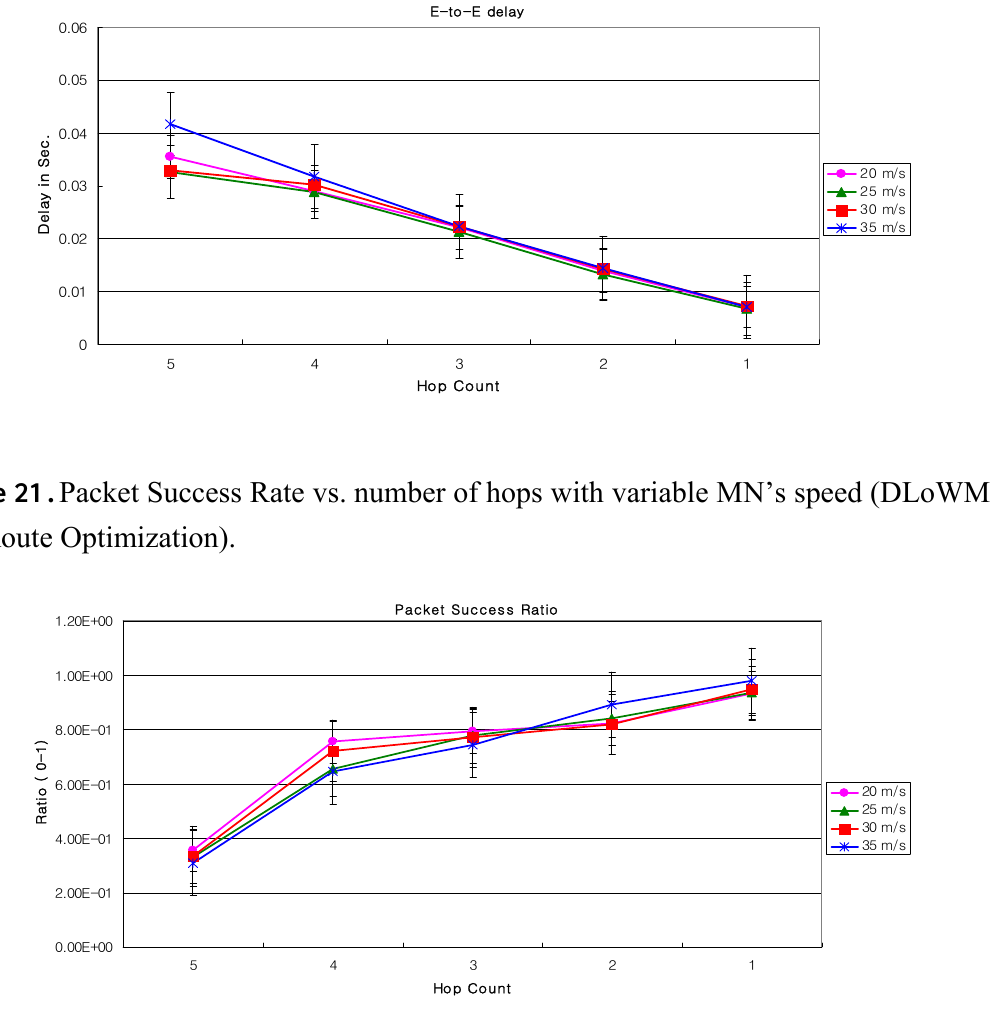
Figure 20. Delay vs. number hops with variable MN’s speed (DLoWMob with Route Optimization).